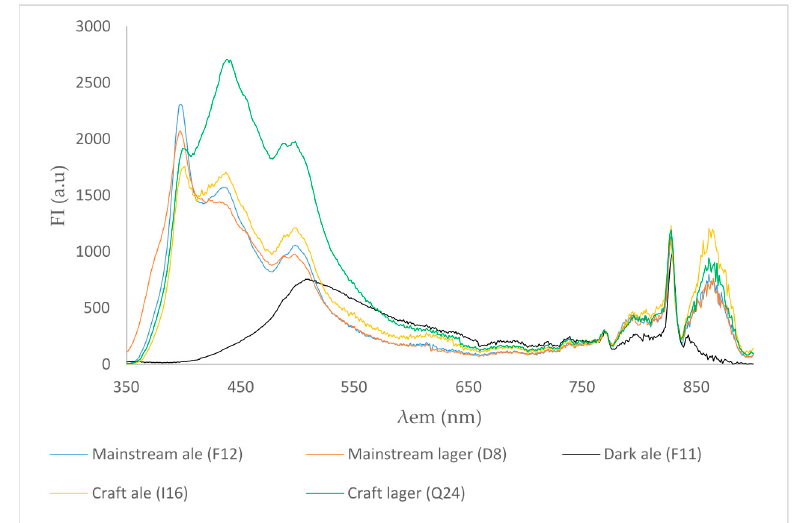
Figure 3. Synchronous scanning fluorescence spectra of select beers showing the differences between a dark ale (F11), craft ales (I16), mainstream ales (F12), craft lagers (Q24) and mainstream lagers (D8).